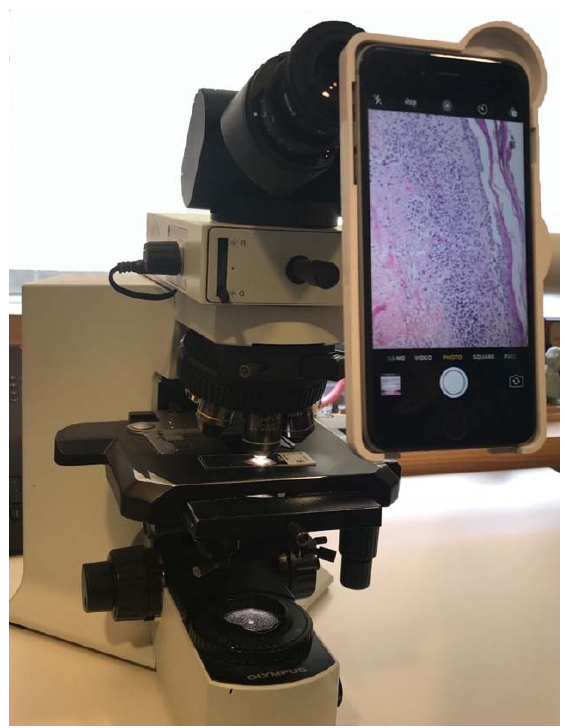
Figure 3. An example of a low-cost method for telepathology, the LabCam smartphone attachment, which allows photography of slides through the eyepiece of any microscope using an iPhone.